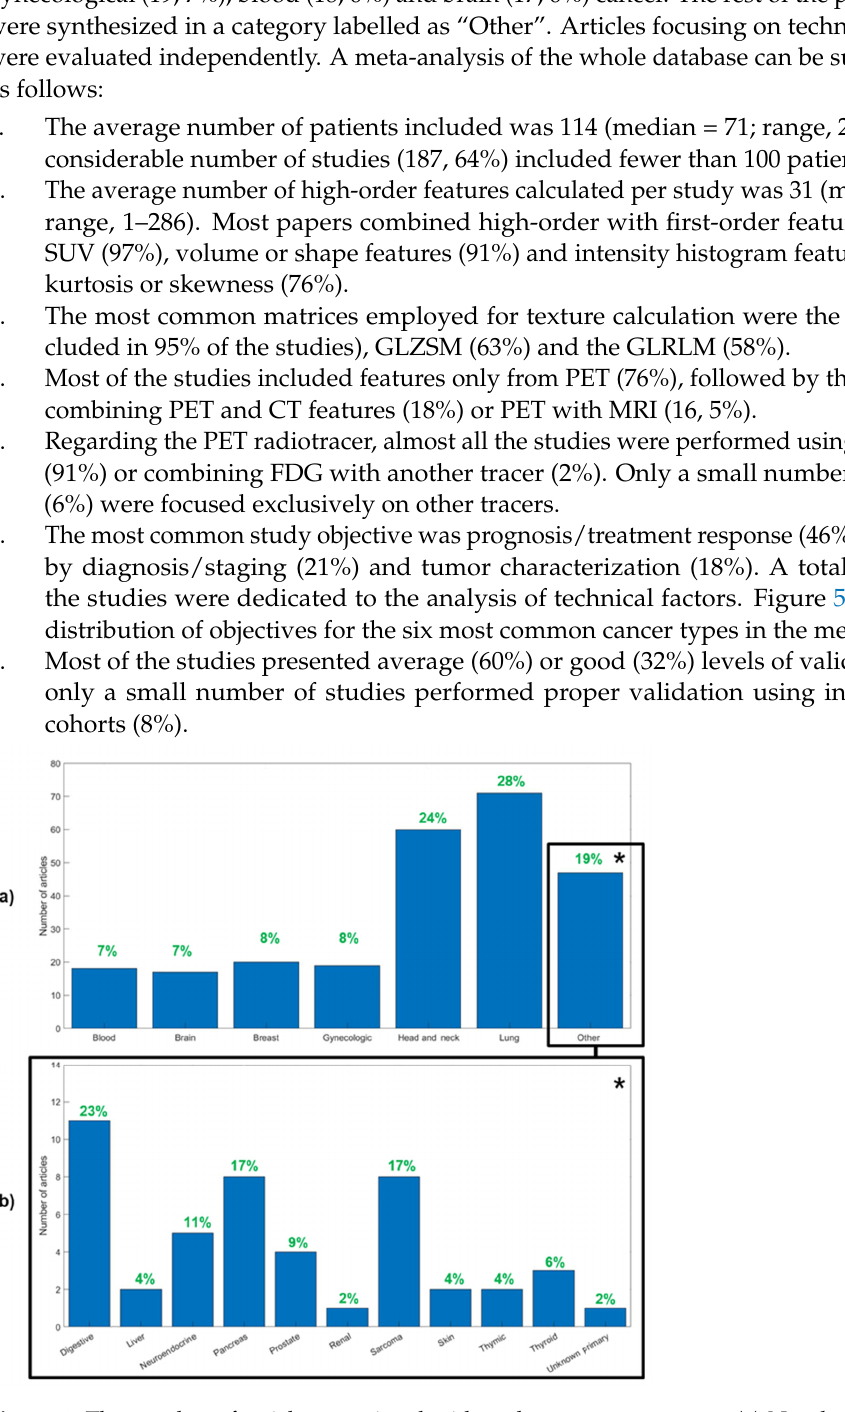
Figure 5. Studies targeting each of the defined objectives segmented by cancer type. ( a ) Lung, ( b ) head and neck, ( c ) breast, ( d ) gynecologic, ( e ) blood, ( f ) brain cancer. 3.2.2. Quality Assessment Out of the 290 publications evaluated, 109 were judged to have a low risk of bias, 131 were judged as having some concerns, and the remaining 50 were at a high risk of bias. A